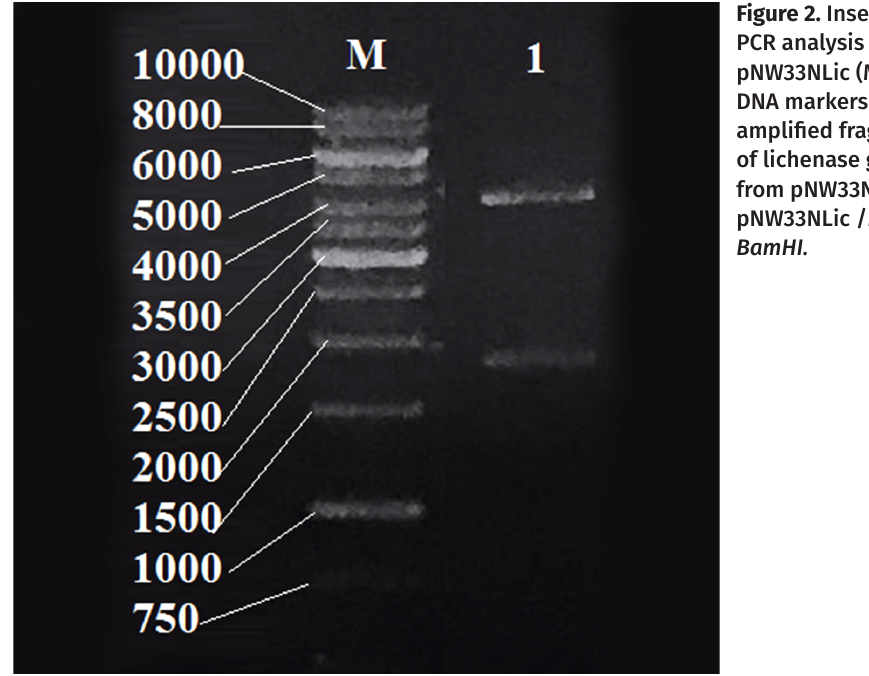
Figure 2. Insert and PCR analysis of E. coli / pNW33NLic (M: 1 kbp DNA markers, 1- PCR amplified fragment of lichenase gene from pNW33NLic, 2- pNW33NLic / HindII and